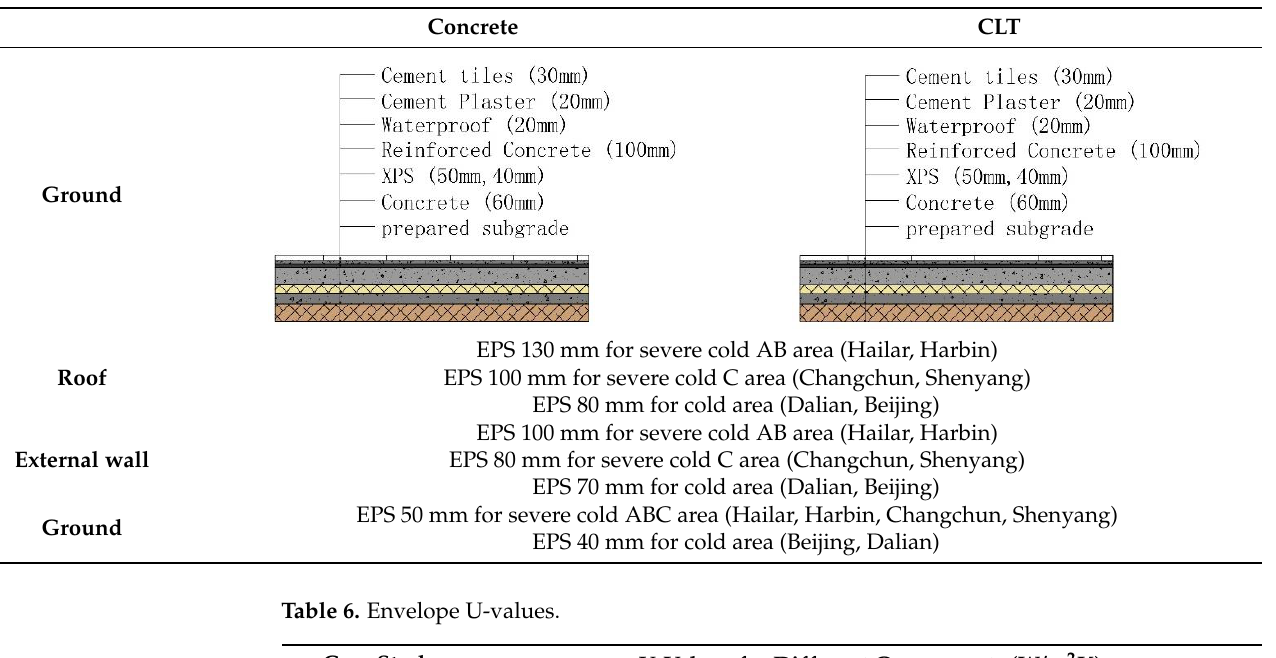
Table 6. Envelope U-values.